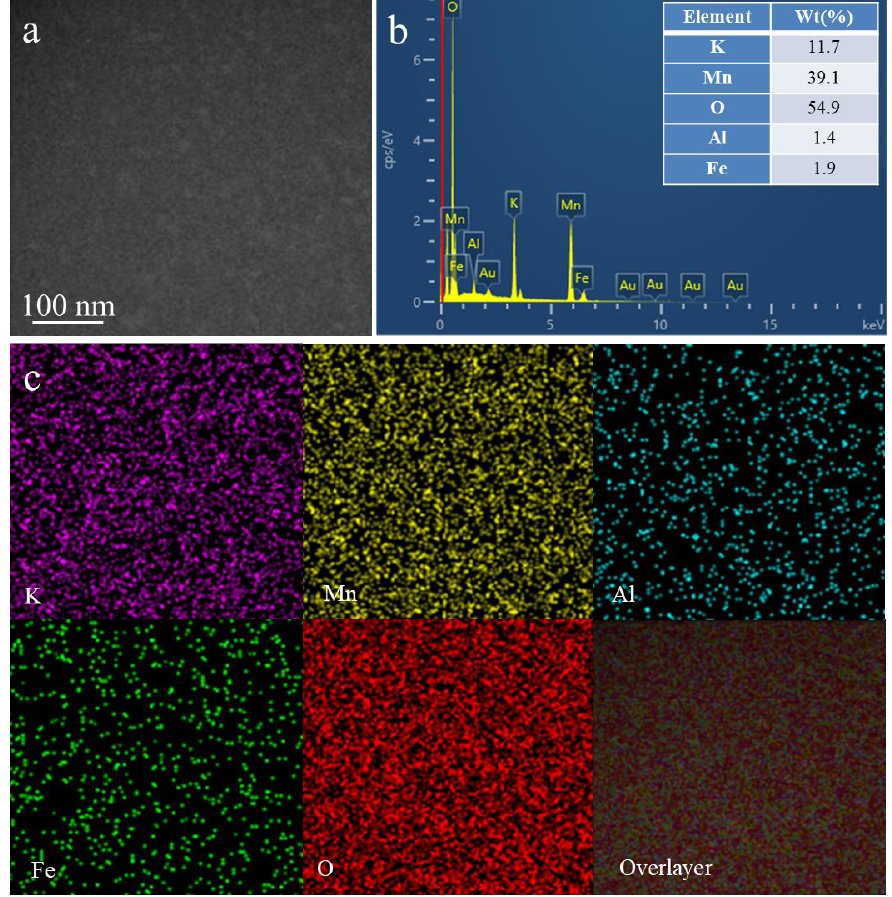
Figure 3. ( a ) ADF image, ( b ) EDX spectrum and ( c ) elemental mapping of